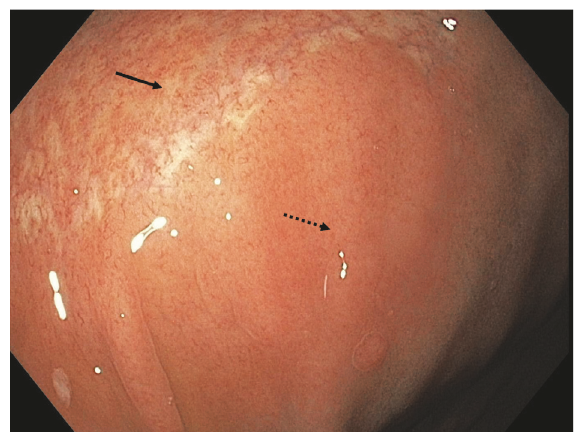
Figure 1: Endoscopic image of gastric mucosa showing an area of cobblestoning (solid arrow) and adjacent normal mucosa (dotted arrow).